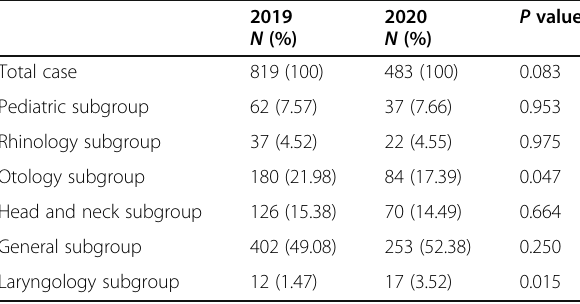
Table 3 Comparison of the total number of outpatient visits between 2019 and 2020 in each Otolaryngology